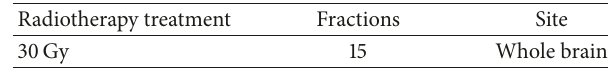
Table 2: Second radiotherapy treatment.